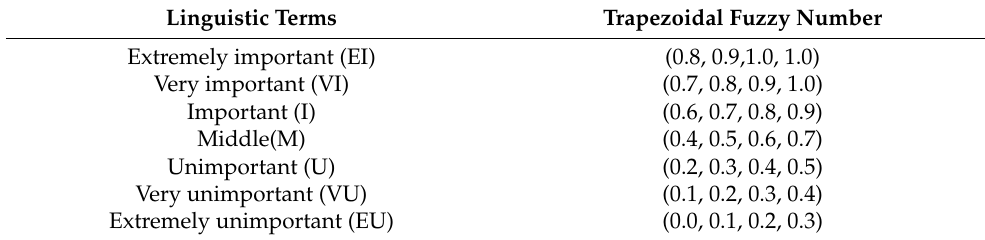
Table 1. Linguistic terms for rating the importance of criteria and the decision makers. Linguistic Terms